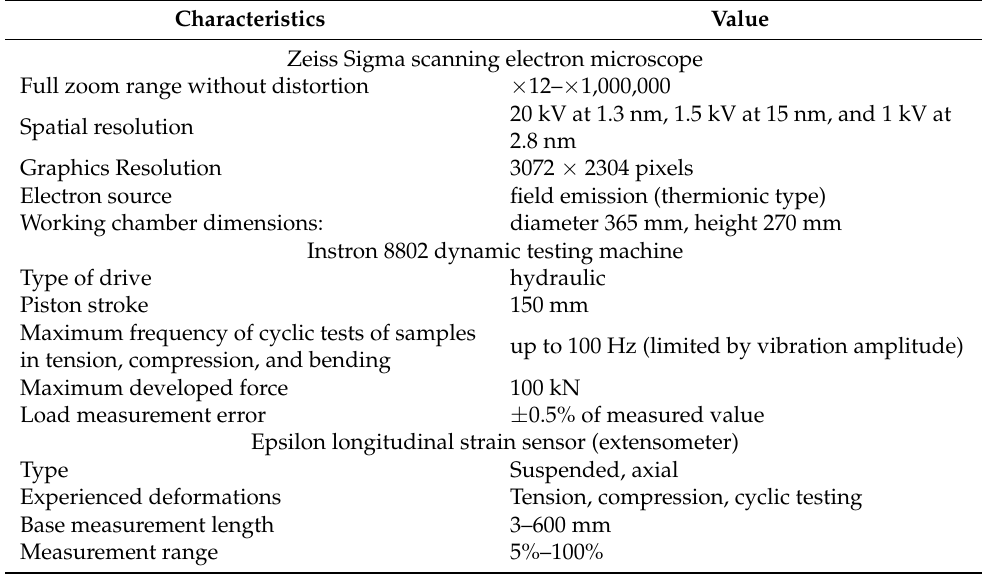
Table 1. Main technical characteristics of the equipment.